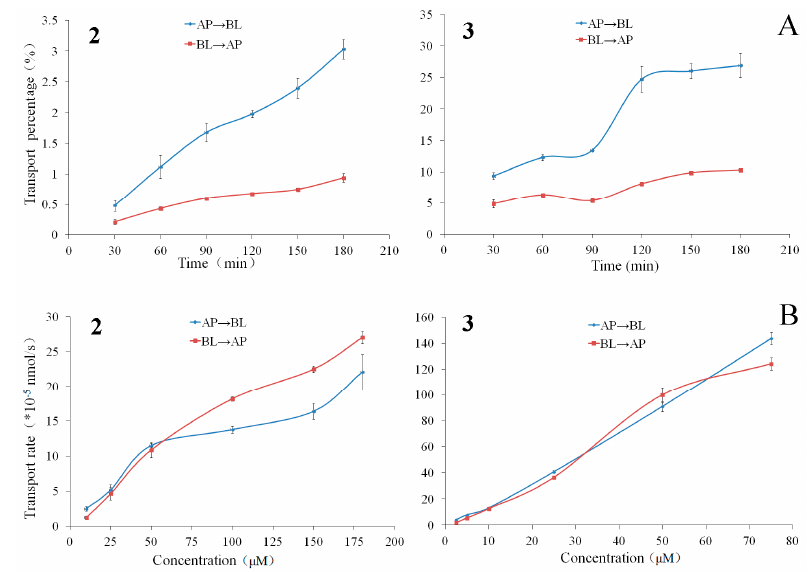
Figure 2. The transport percentage as a function of time at 50 µM ( A ) and transport rates as a function of concentration at 90 min ( B ) of the compounds 2 and 3 in Caco-2 cell monolayer. Data are the mean ± S.D ( n = 3).